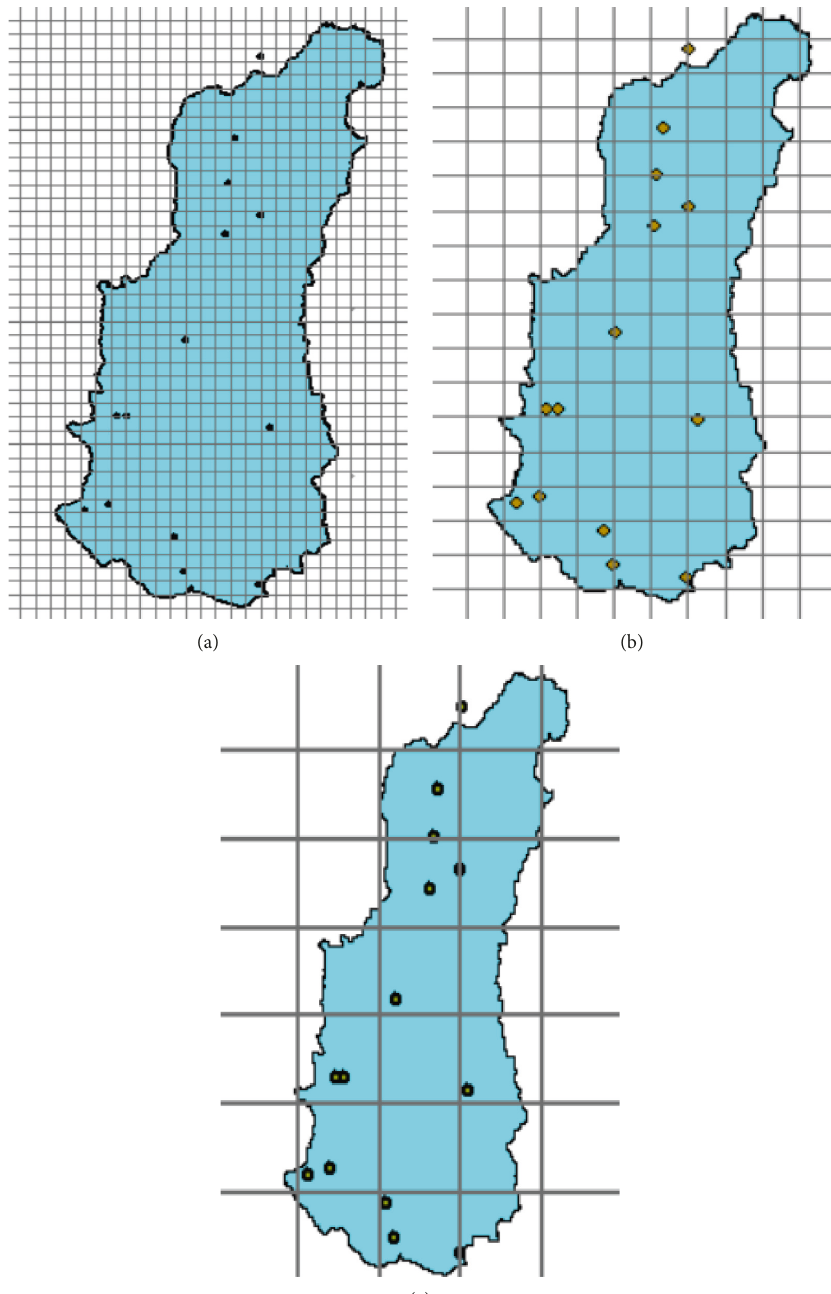
Figure 2: Grid layout and location of RGs. (a) For 0.04 ° × 0.04 ° . (b) For 0.10 ° × 0.10 ° . (c) For 0.25 ° × 0.25 °